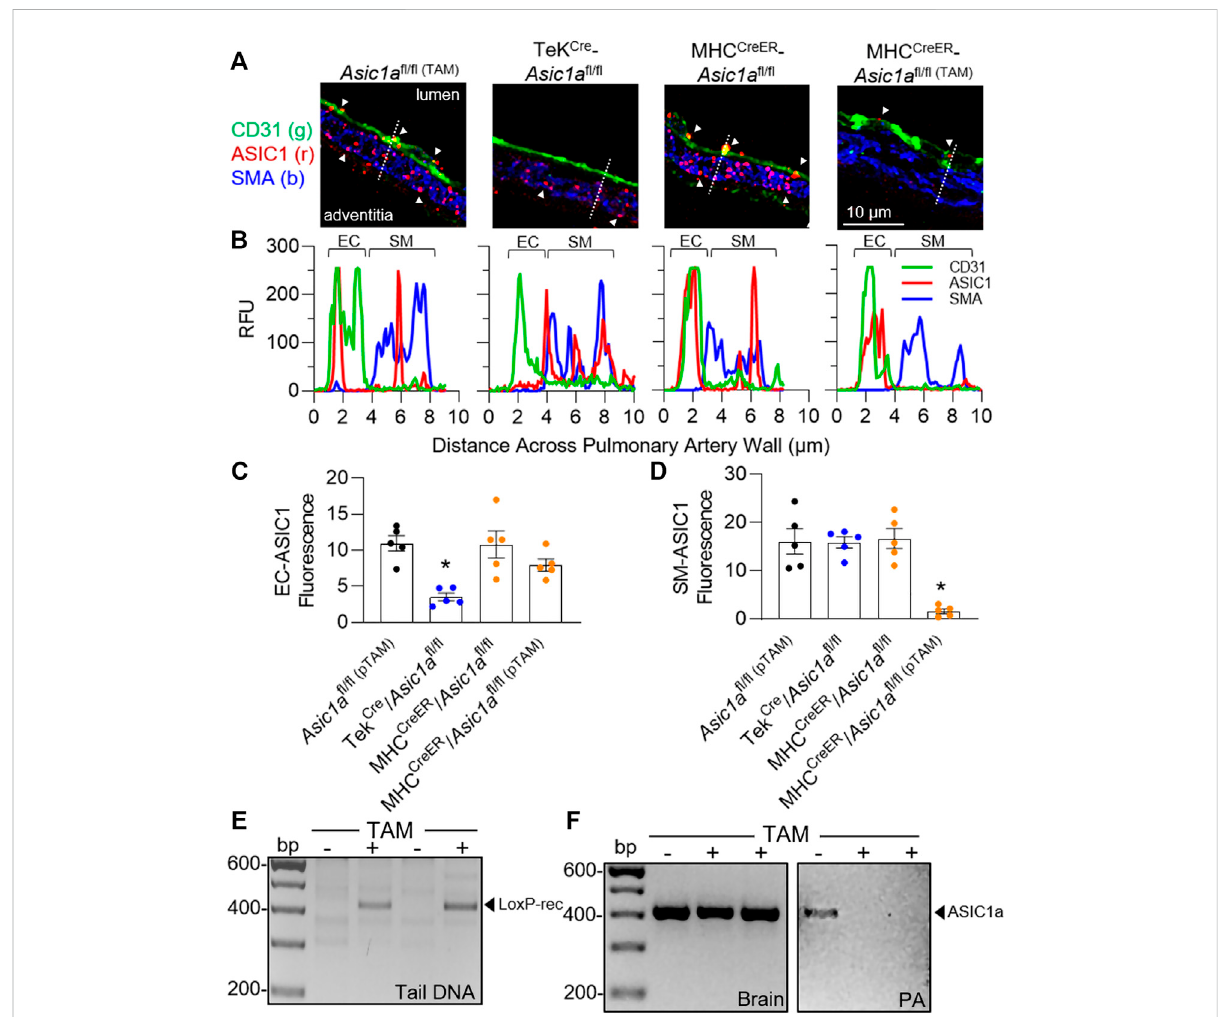
FIGURE 3 Characterization of transgenic mice. (A) Representative immuno fl uorescence for ASIC1 (red), CD31 (green), and SMA (blue) in pulmonary arteries from lung sections of Asic1a fl / fl (TAM) , TekCre- Asic1a fl / fl , and MHC CreER - Asic1a fl / fl mice treated with vehicle or tamoxifen (TAM). White arrowheadsshowpunctateimmuno fl uorescenceofASIC1inECorSM.Thedottedlineineachimageindicatesthelinepro fi leshownin (B) ofrelative fl uorescenceunitsacrossthearterywallfromlumentoadventitia.SummaryanalysisofASIC1expressionineither (C) ECor (D) SMofpulmonary arteries from lung sections. n = 5 animals per group; analyzed by one-way ANOVA and individual groups compared with Š ídák ’ s multiple comparisons tests. (E) PCR of tail DNA showing Cre-mediated LoxP recombination and excision of targeted Asic1a in the same MHC CreER - Asic1a fl / fl mouse before (-) and after (+) tamoxifen (TAM) treatment. (F) Asic1a mRNA expression in brain tissue and intrapulmonary arteries (PA) in MHC CreER - Asic1a fl / fl mice with vehicle (-) or TAM (+). Scanned images of the blots were inverted and adjusted for